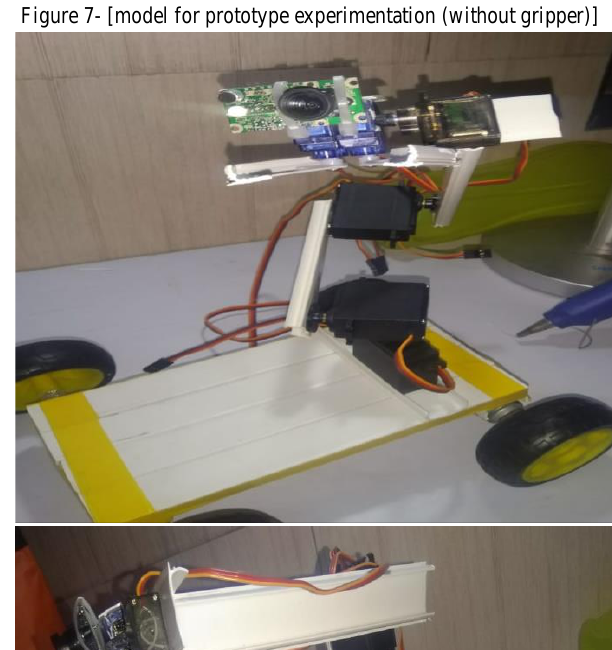
Figure 7- [model for prototype experimentation (without gripper)]